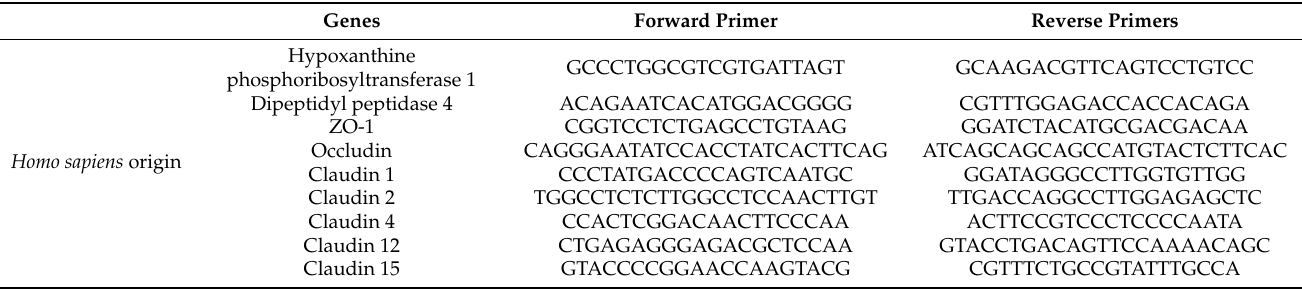
Table 3. Primers used for the qPCR